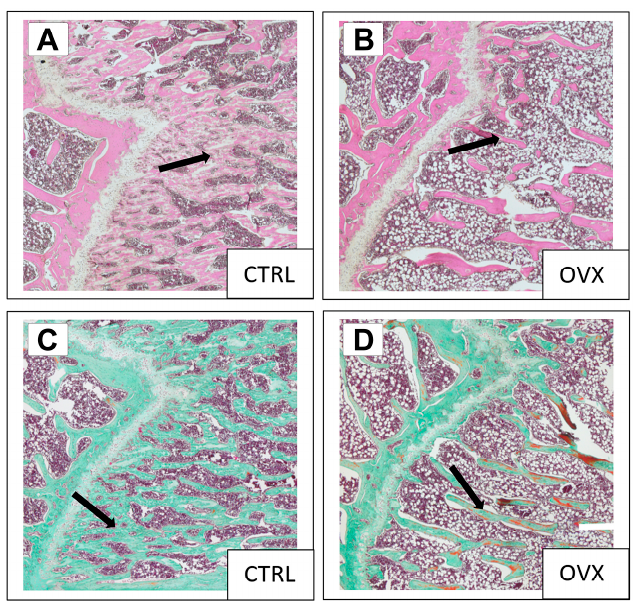
Figure 3. Representative distal metaphyseal femur with H&E staining (top) and Masson–Goldner staining (bottom) confirming the induced osteoporotic bone phenomenon in the OVX group compared to the CTRL group using reduced trabecular density (arrows). CTRL ( A ) and OVX ( B ) animals with H&E staining, compared to CTRL ( C ) and OVX ( D ) rats with Masson-Goldner